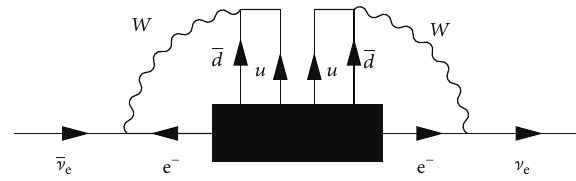
Figure 5: Diagram representing the contribution of the “black box” operator to the Majorana mass. Figure from